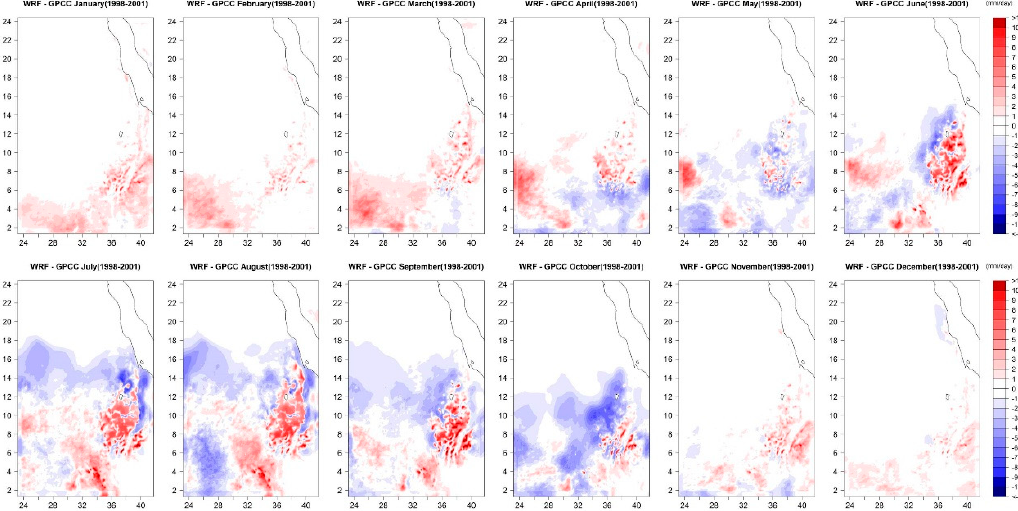
Figure 3. Bias (values obtained with the WRF simulation—values from the Global Precipitation Climatology Center (GPCC) dataset) for the average precipitation each month (mm/day) over the ENB during the period 1998–2001, Longitude on the horizontal axis and latitude on the vertical axis